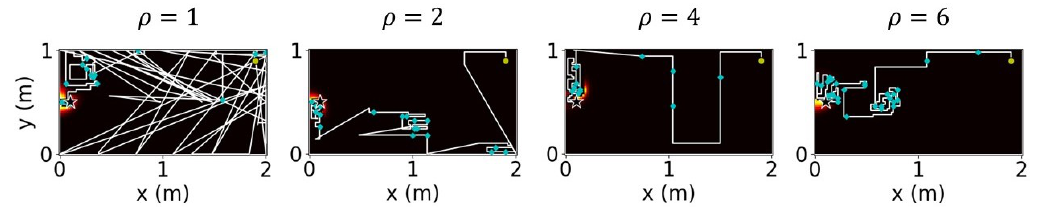
Figure 12. Trajectories of the agent with different stand-out coefficients. The star indicates odor source location.